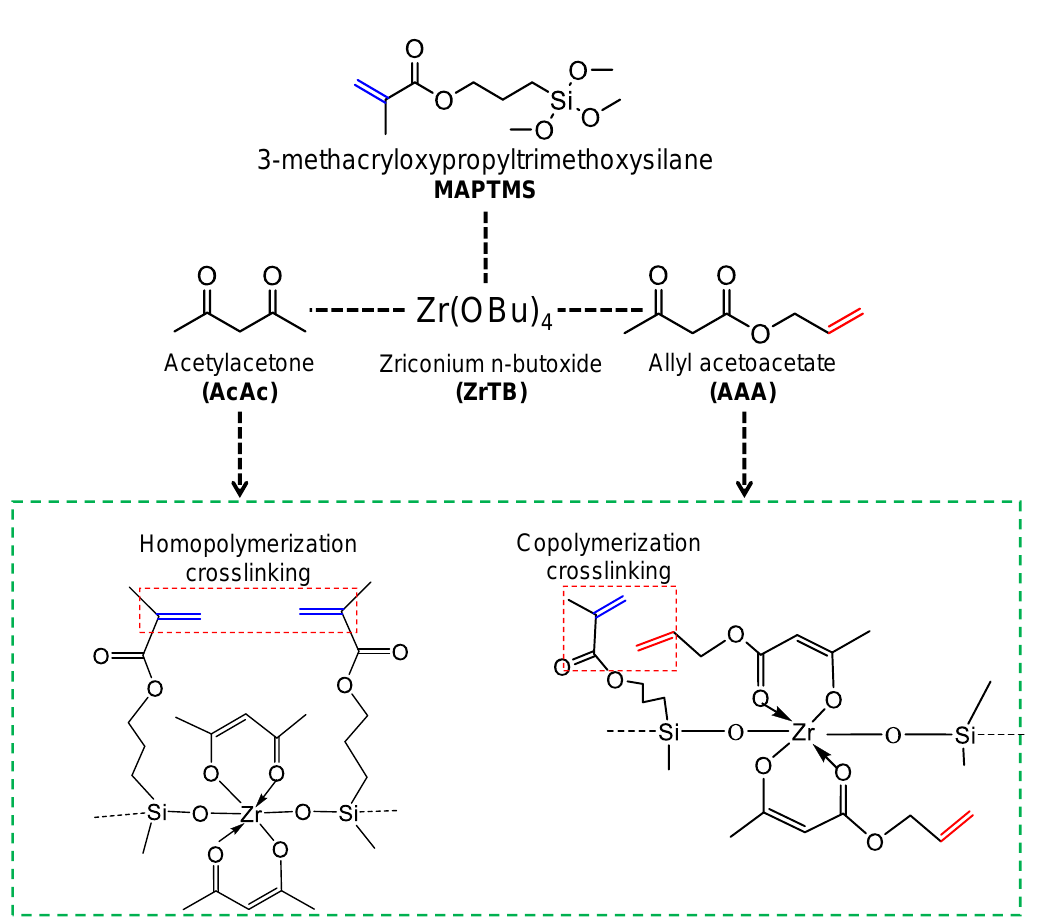
Figure 13. Comparison of the structural elements and formation schemes of different hybrid polymers derived from acetylacetone and allyl acetoacetate ligands.